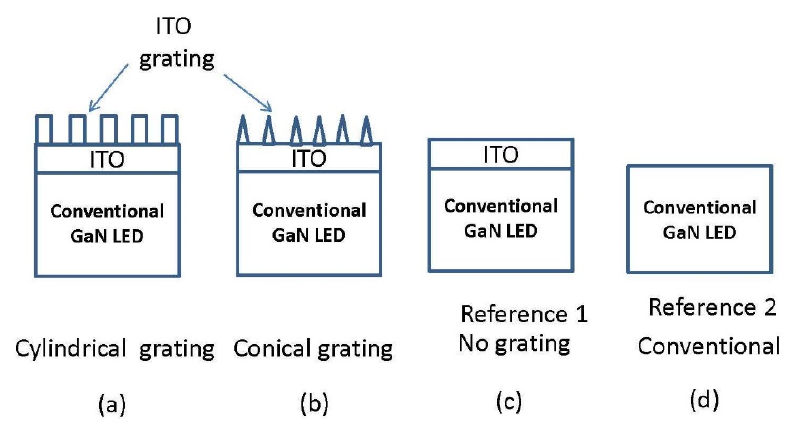
Figure 3. The schematic diagrams of the top grating simulation of ( a ) cylindrical pillar grating, ( b ) conical pillar grating, ( c ) conventional LED (CLED) with Indium Tin Oxide (ITO) layer, and ( d ) conventional LED.